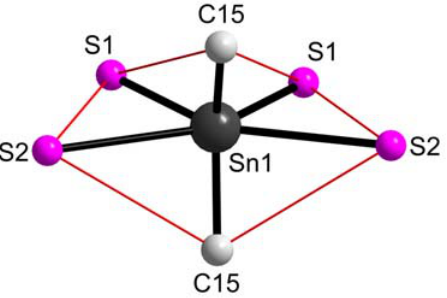
Figure 4. Skew trapezoidal bipyramidal view of the complex [ ( n -Bu)